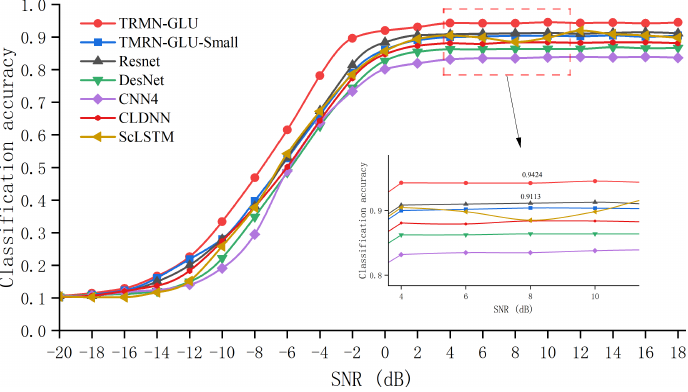
Figure 10. Classification accuracy of DL models under different SNR.